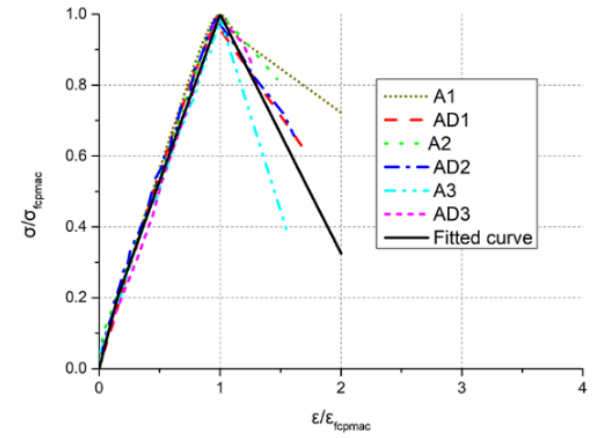
Figure 14. The dimensionless stress–strain curve and fitted curves.